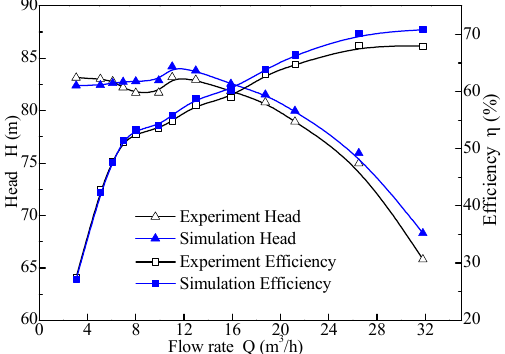
Figure 6. Head and efficiency performance in the simulation and experiment.